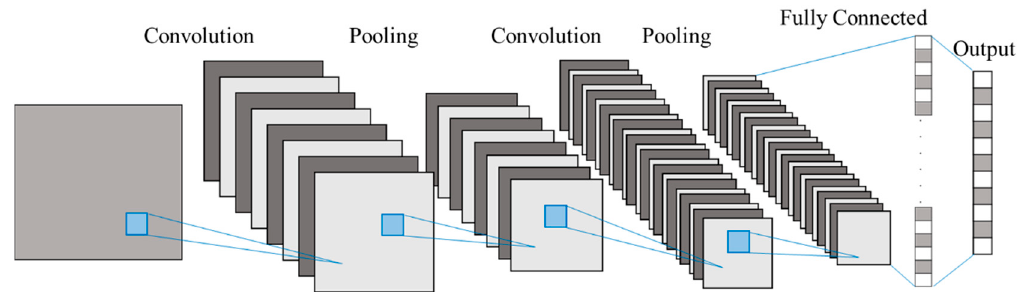
Figure 1. The architecture of the generally used convolutional neural network (CNN) [20].